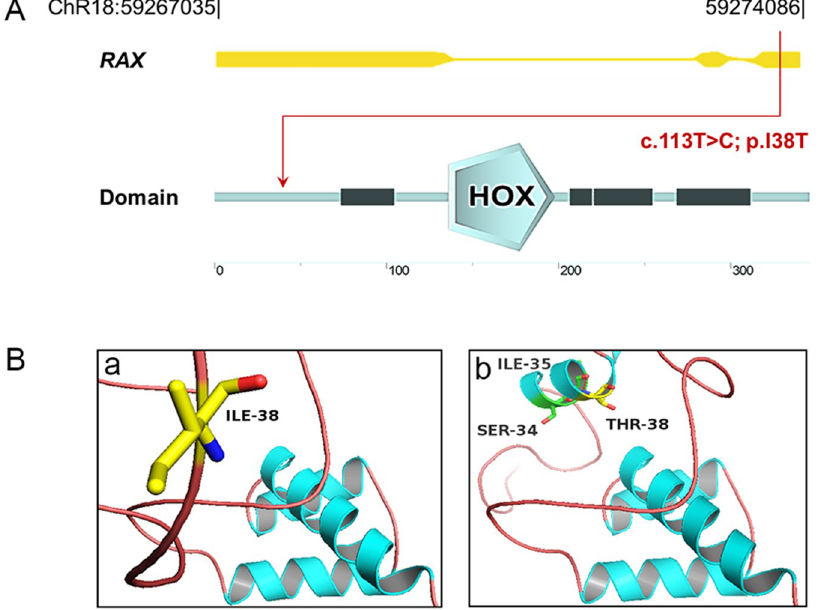
Figure 4. Modeling structure analyses of RAX mutation. ( A ) Map of 7.05 kb RAX gene. Predicted RAX domain structure. Homeobox is indicated in light blue and low complexity region is indicated in dark blue. ( B ) Predicted crystal structure of the RAX wide type and mutant type including homeobox domain of RAX (residue136-198). A view of residue 38 highlighting the WT (isoleucine) and mutated (threonine) at the position is in the two bottom